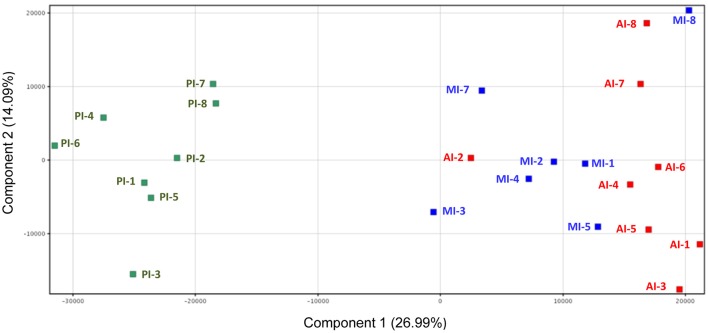
Principal component analysis of the gene expression profile of intestine sections of European sea bass. Anterior intestine samples are marked as AI (red), middle intestine as MI (blue) and posterior intestine as PI (green).